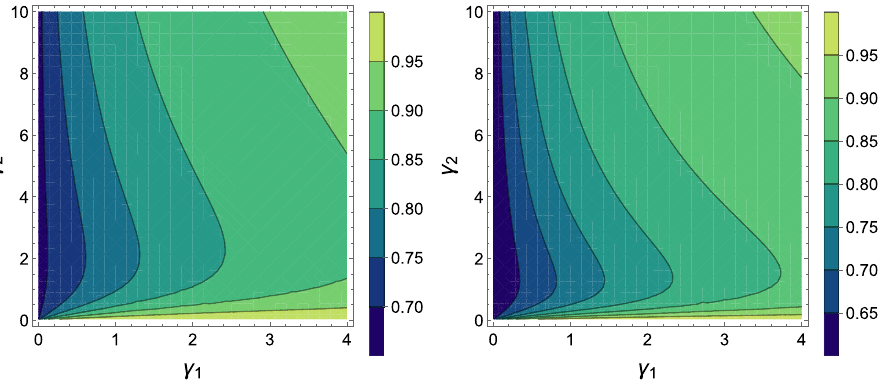
Figure 5. Contour plots of the coherence of state ρ in Eq. (4) corresponding to ¯ n b = 0 and ¯ n a = 1 (left) and ¯ n = 2 (right) as a function of γ 1 and γ 2 , with J = 1 and D = 1 for both panels. a